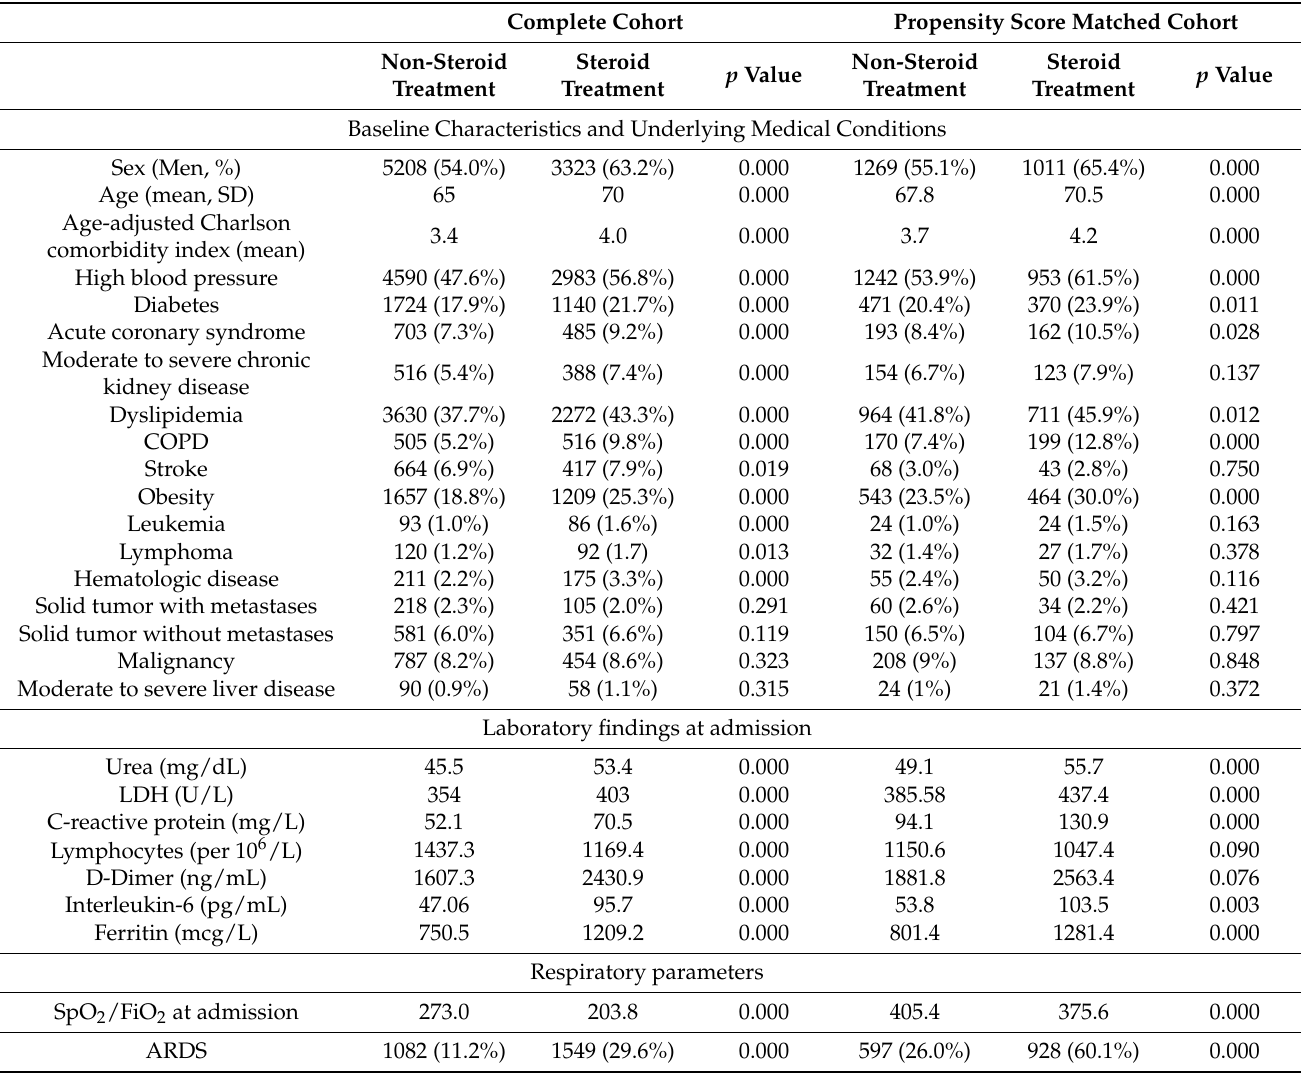
Table 1. Baseline characteristics of patients in the steroid and non-steroid complete cohort and in the propensity-matched cohort.